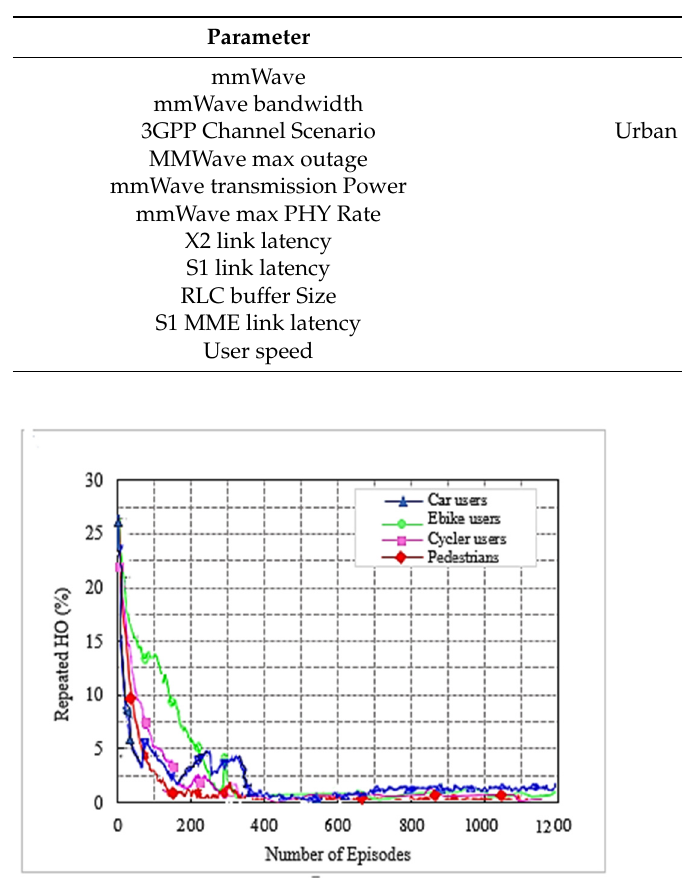
Table 2. Simulation Parameter Table [1].